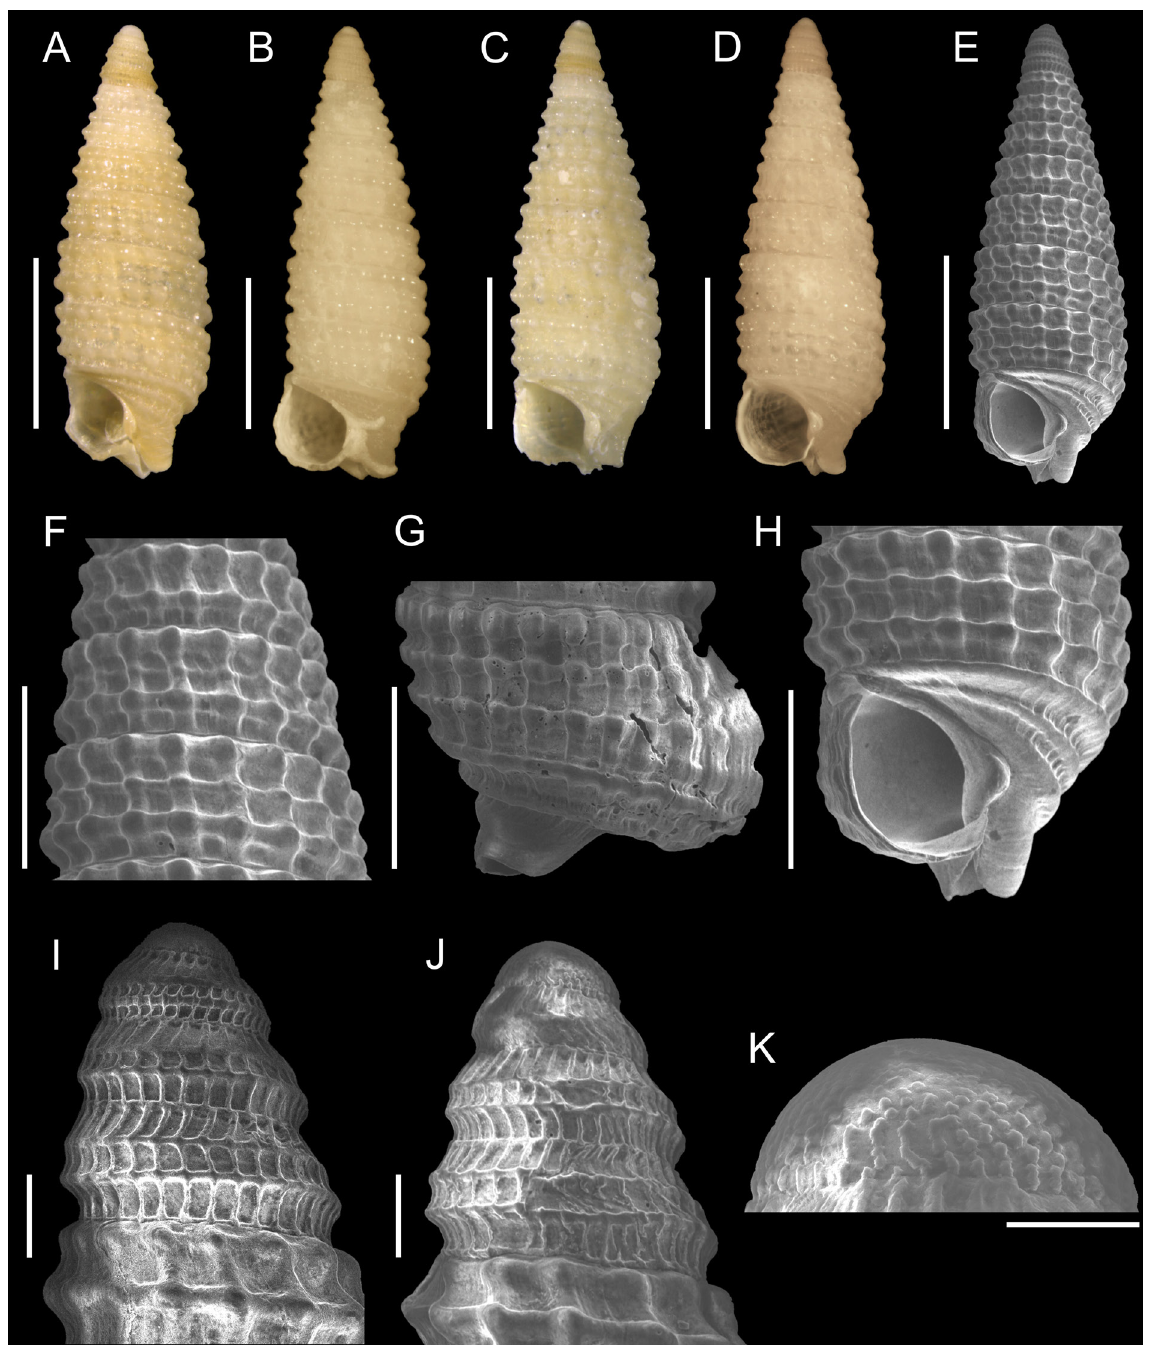
Fig. 15. Sagenotriphora sp. 1. A . MNRJ 34457*, 2.66 mm. B . MNRJ 32560*, 2.82 mm. C . MNRJ 32562*, 2.95 mm. D–E . MNRJ 32579*, 2.83 mm. F, H–I . Same shell as D. G . Same shell as B. J–K . MNRJ 32560. Scale bars: A–E = 1 mm; F–H = 500 µm; I–J = 100 µm; K = 50